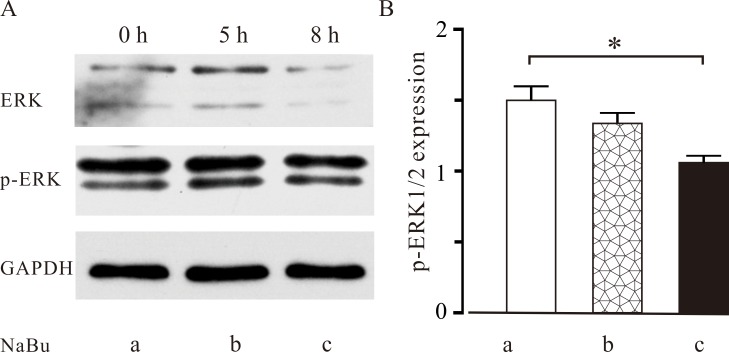
Effects of NaBu treatment on the expression of ERK and p-ERK in mouse oocytes at the MI stage.Mouse GV stage oocytes were collected and randomly assigned into three groups. GV stage oocytes were cultured in KSOM without NaBu for 8 h as a negative control (group (a)). In group (b), GV stage oocytes were cultured in KSOM for 3 h followed by culturing in KSOM supplemented with 2.0 mM NaBu for 5 h. In group (c), GV stage oocytes were cultured for 8 h. After 8 h of culture, the oocytes at the MI stage in these three groups were lysed to extract their total proteins. Then, western blotting was performed to detect to expression of p-ERK and ERK in groups a (left), b (central), and c (right). (B) Summary of ratios of p-ERK/ERK in (A). *: P < 0.05. These data suggest that NaBu treatment reduced the ratio of p-ERK/ERK in MI stage oocytes.